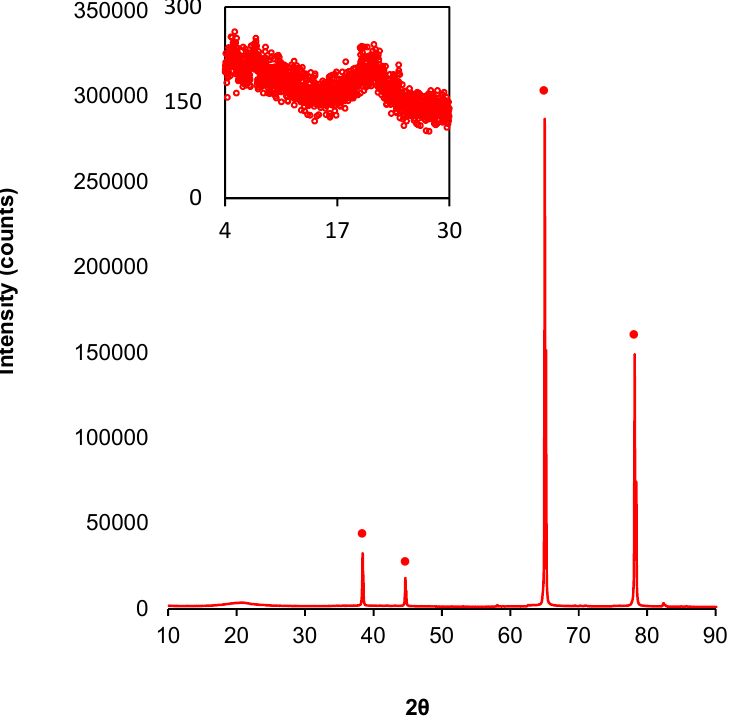
Figure 4. XRD peaks in the inset indicate well-organized layers from an organic lamellar structure at 2 θ = 20.798°. Peaks from the aluminum substrate ( ● ) are indicated in the di ff ractogram.